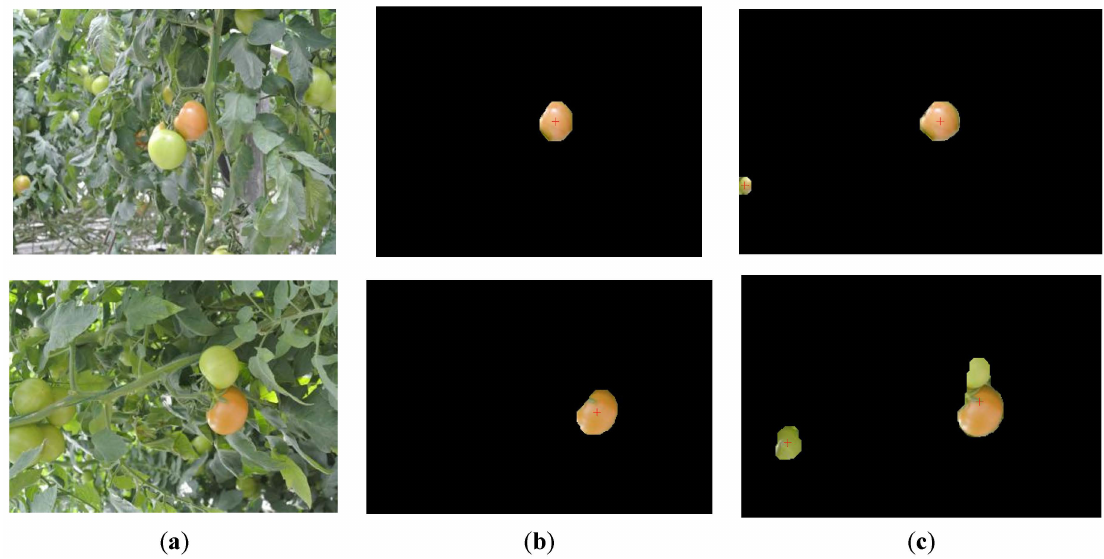
Figure 5. The results of comparative tests between proposed approach and the simple fusion strategy: ( a ) Original images; ( b ) Results of proposed algorithm; ( c ) Results of simple